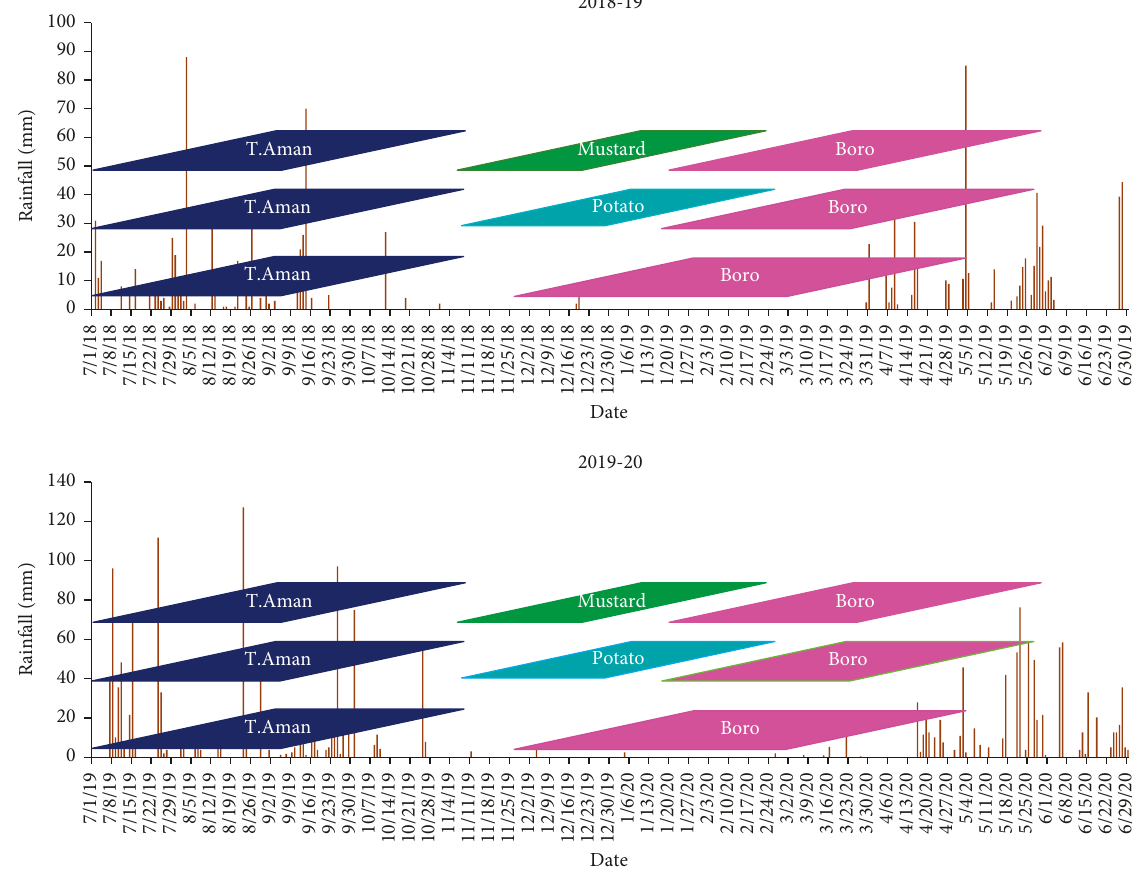
Figure 2: Rainfall distribution in three cropping patterns at Mithapukur and Pirganj of Rangpur during 2018–2019 and 2019–2020 seasons.